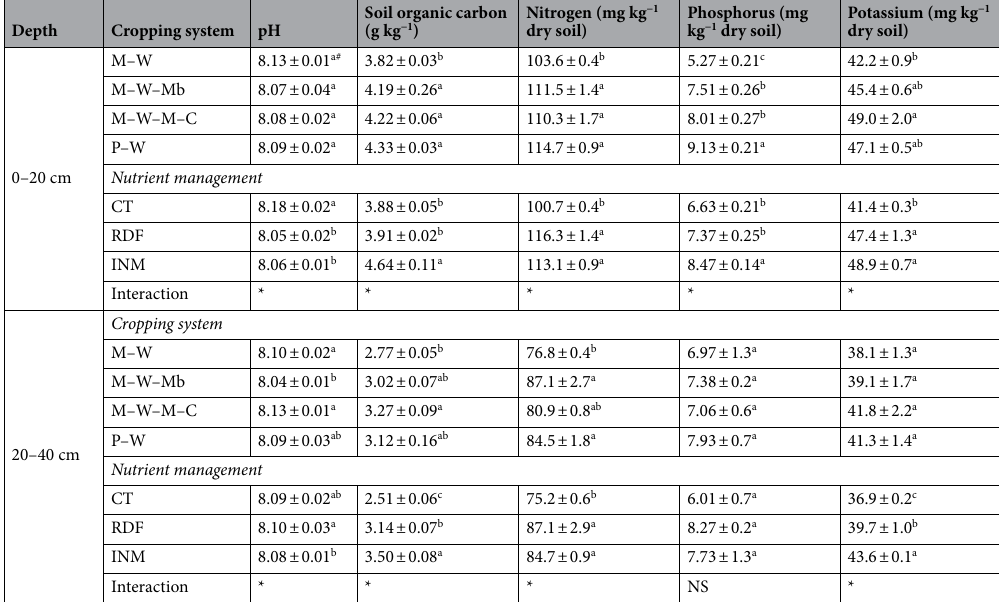
Table 3. Impact of pulses and organic amendments on soil chemical properties after 14 years. #